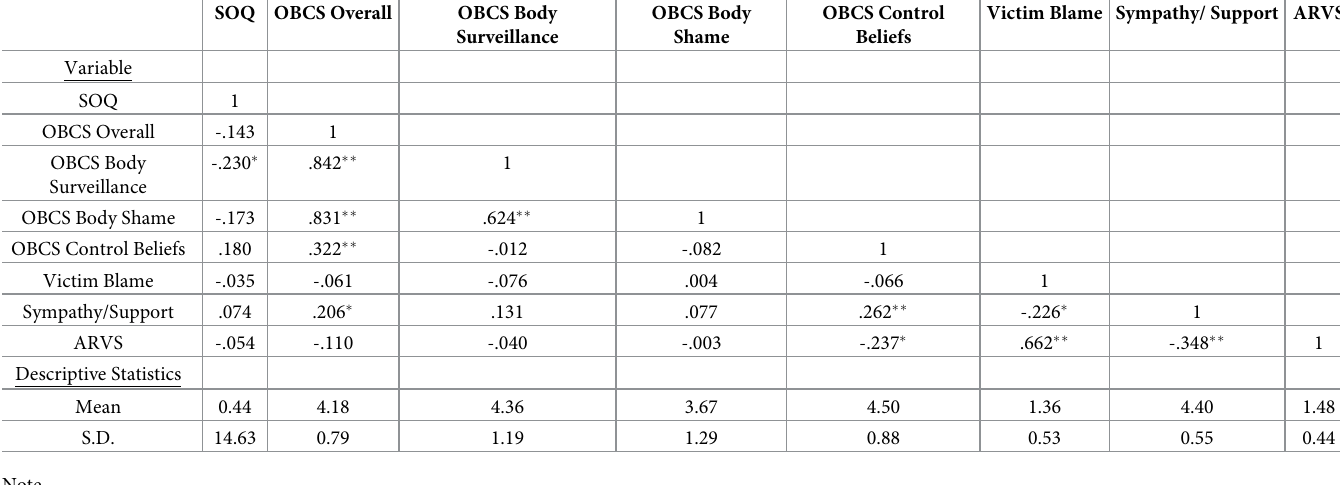
Table 2. Correlations and descriptive statistics among study two variables. SOQ OBCS Overall OBCS Body